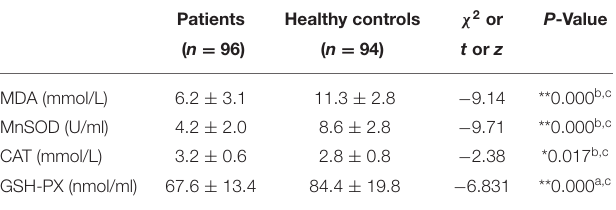
TABLE 2 | Oxidative stress levels of schizophrenia patients and healthy controls (Mean ± SD).